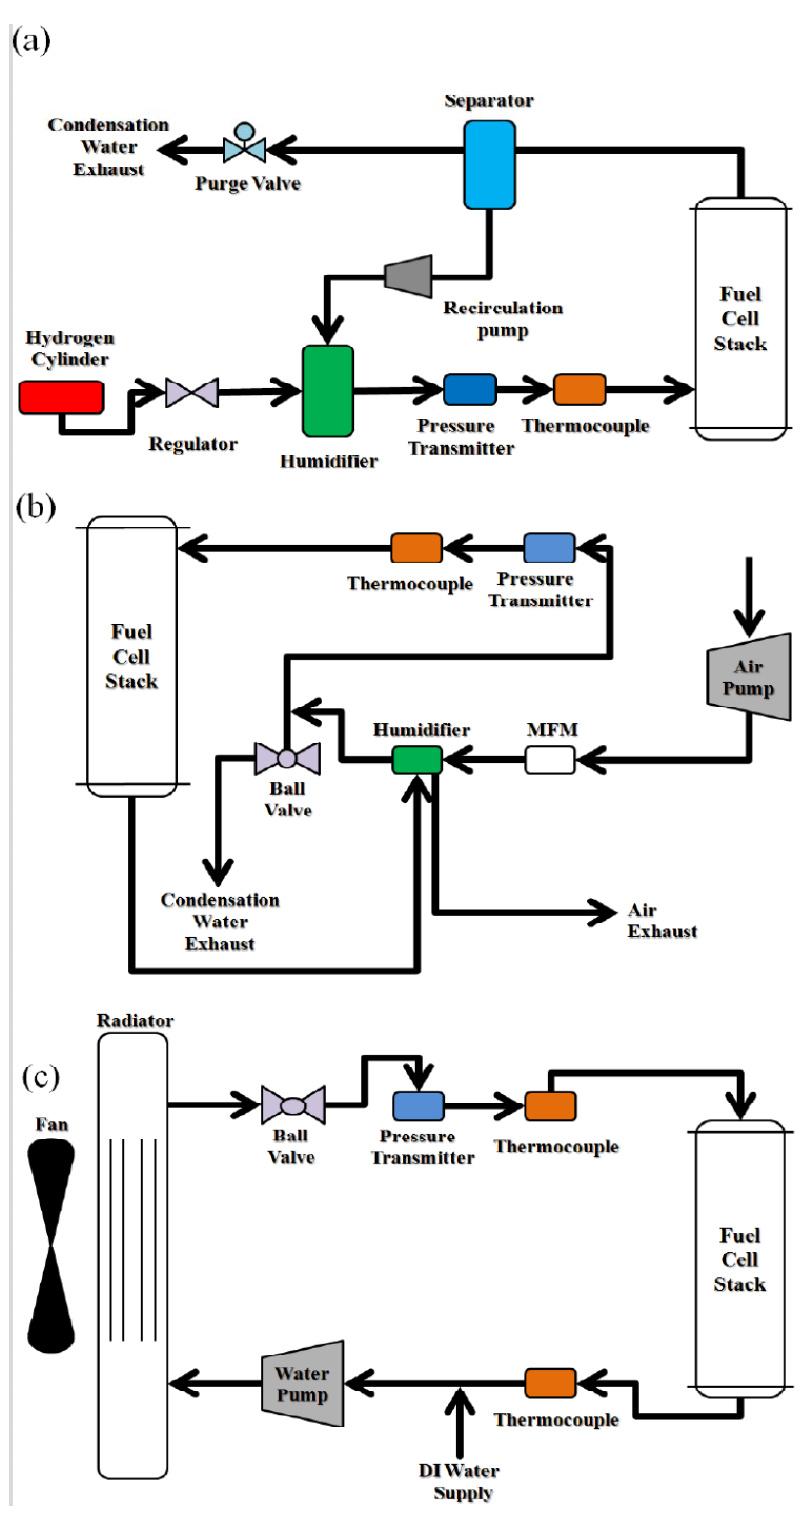
Figure 3. The new compact design of fuel supply, oxidant supply and water cooling system in the NTU